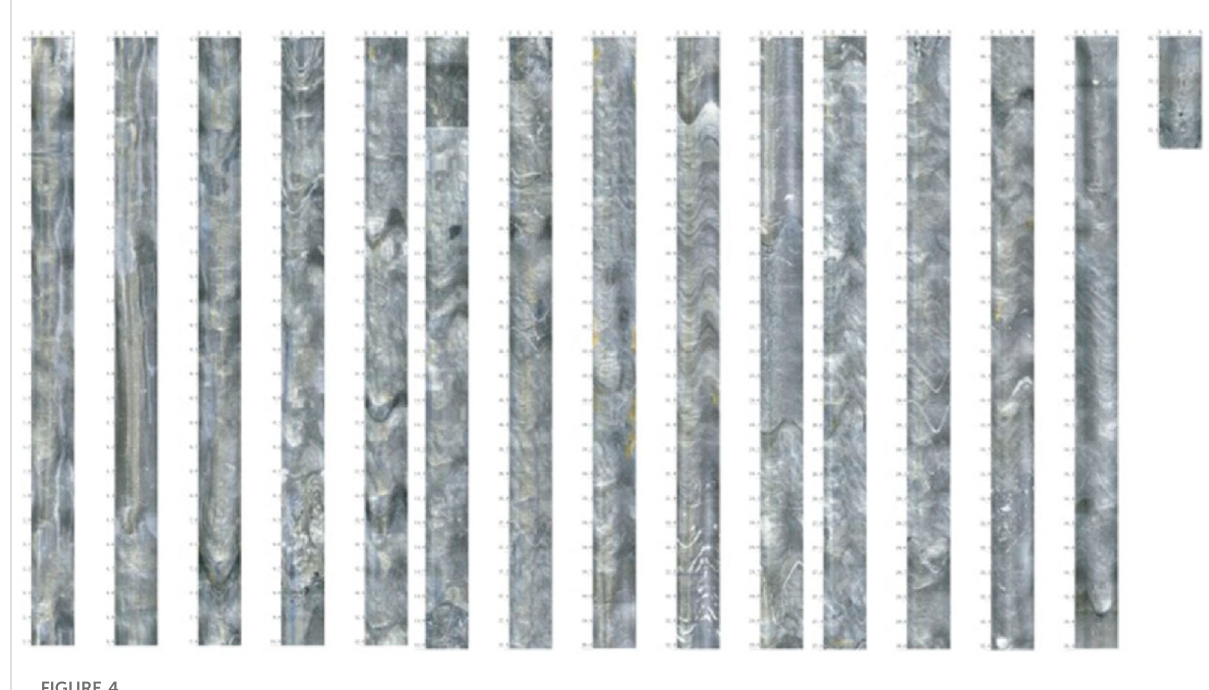
FIGURE 4 Inner wall peep map of 0 – 35 m borehole of the coal seam roof.